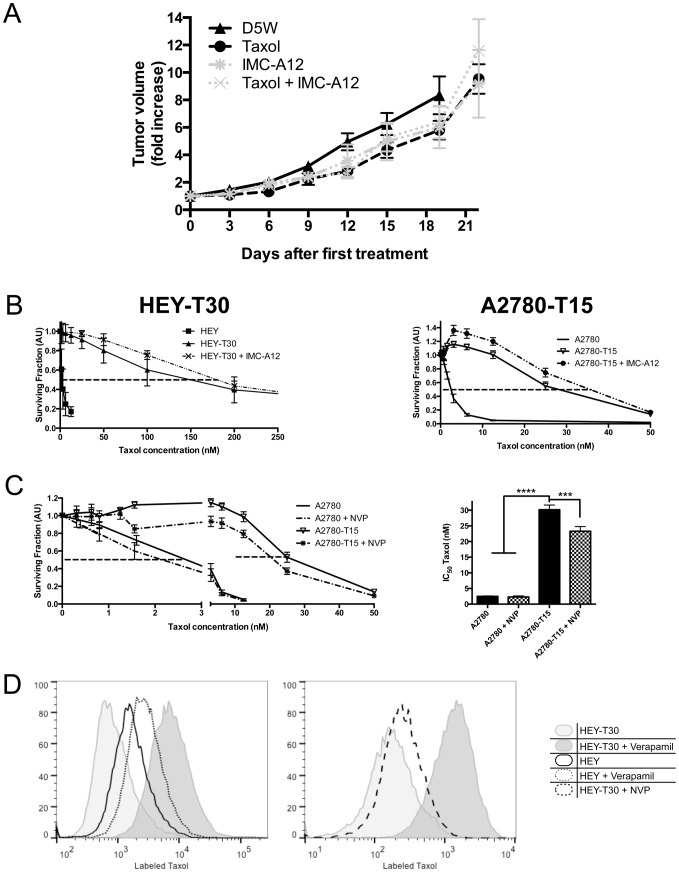
IGF1R-specific inhibition does not alter Taxol resistance.(A) Combination treatment using Taxol and IMC-A12 in mice with HEY-T30 xenografts. HEY-T30 xenografts were grown as described in Figure 2D, then treated with Taxol (black circles), according to the same dose/schedule described in Figure 2D, or with IMC-A12 (intraperitoneal injection of 40 mg/kg three times per week, grey *), or with combination treatment of Taxol and IMC-A12 (grey x). Data points show the mean tumor volume±SEM for each treatment group (n = 8 animals per group). No significant differences in tumor volume were observed with IMC-A12 or combined Taxol/IMC-A12 treatment compared to D5W or Taxol alone. This experiment was repeated a second independent time with similar results. (B) Effect of IMC-A12 on Taxol sensitivity, evaluated by SRB cytotoxicity assay. In 96-well plates, cells were treated with serial dilutions of Taxol alone (solid lines) or together with a fixed dose of 10 µg/ml IMC-A12 (dashed lines). Dose response curves show the mean of the surviving fraction±SEM of cells relative to untreated cells at the indicated Taxol concentrations (n = 7 independent experiments, each done in six replicates). No significant Taxol sensitization was observed in the presence of IMC-A12. (C) Effect of NVP-AEW541 on Taxol sensitivity, evaluated by SRB cytotoxicity assay. In 96-well plates, cells were treated with serial dilutions of Taxol alone (solid lines) or together with a fixed dose of 1 µM NVP-AEW541 (dashed lines). Dose response curves show the mean±SEM of the surviving fraction of cells relative to untreated cells at the indicated Taxol concentrations. The bar graphs depict the IC50 of Taxol for the indicated cell lines and drug treatments, and show the mean±SEM calculated from at least four independent experiments (each done in six replicates). NVP-AEW541 sensitizes A2780-T15 to Taxol. ***p<0.001, ****p<0.0001; One-way ANOVA with Bonferroni posttest. (D) ABCB1 (p-glycoprotein) function in HEY and HEY-T30 in the presence and absence of NVP-AEW541. Cells were incubated with labeled Taxol (Oregon Green 488 Taxol, bis-acetate) in the presence or absence of NVP-AEW541 or verapamil. The ABCB1-overexpressing HEY-T30 cells (light gray shaded graph) retain less labeled Taxol than HEY cells (unfilled black outline). Verapamil, a known p-glycoprotein inhibitor, markedly increases the retention of labeled Taxol in HEY-T30 cells (and to a lesser degree in HEY cells), as demonstrated by the rightward shift of the peaks. Shown in the right panel with the dashed black line, treatment with 1 µM NVP-AEW541 does not appear to affect retention of labeled Taxol in HEY-T30 cells. Two independent experiments were done with similar results.